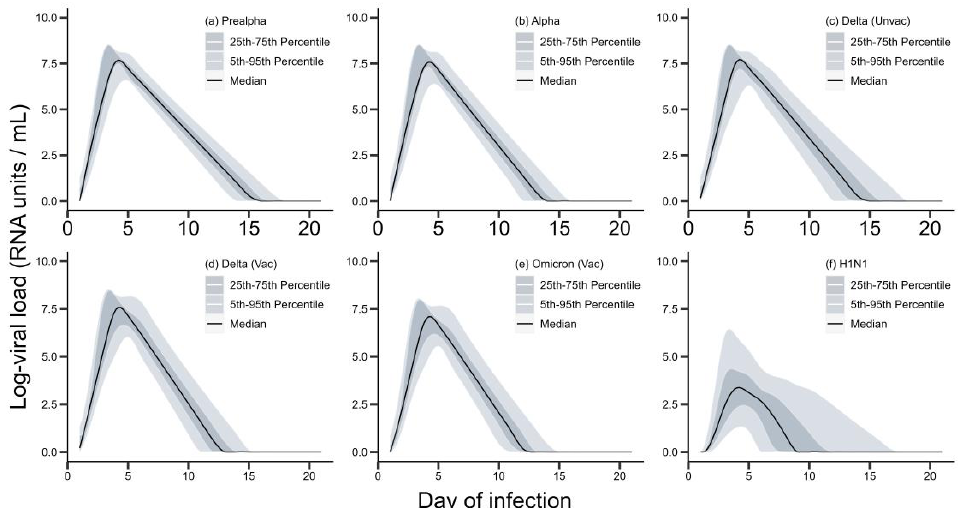
Figure 4. Log viral loads of virus variants by day of infection for ( a ) prealpha, ( b ) alpha, ( c ) delta (unvaccinated), ( d ) delta (vaccinated), ( e ) omicron (vaccinated) and ( f ) influenza A-H1N1. The median, 25th, 75th, 5th and 95th percentiles of log viral loads are presented by day of infection for each virus variant. All log viral loads and their rates of change are reported in log mRNA units/mL. The log viral load medians and percentiles for all the SARS-CoV-2 variants follow qualitatively similar trajectories, with relatively narrow percentile bands around a uni- modal median curve, having peaks around 7.5 on day 4. The variant with the lowest me- dian peak, omicron (vaccinated), had a peak log viral load of 6.99 (4.67, 7.76) on day 4. Delta (unvaccinated) showed the widest percentile bands among the SARS-CoV-2 vari- ants. The percentile bands for influenza A-H1N1 are much wider, and the unimodal me- dian curve has a much lower peak at 3.36 (1.28, 6.06) on day 4. Similar average rates of decline characterized the median curves of prealpha, alpha and delta (unvaccinated) as well as of influenza A-H1N1 with rates of 0.635, 0.683, 0.692 and 0.672 per day, respec- tively. Delta (vaccinated) and omicron (vaccinated) showed higher average rates of de- cline of 0.830 and 0.777, respectively. The viral load trajectories of the five SARS-CoV-2 variants studied have relatively small quantitative differences. One of the main differences is in the variance in the viral load on a given day of infection, with the largest variances exhibited by delta (unvac- cinated). In contrast, the viral load trajectories of influenza A-H1N1 reflected much greater variances in viral load on given days of infection. This suggests a higher frequency for influenza A-H1N1 of unusually high and unusually low viral loads relative to the median for given days, as well as a higher frequency of longer infections. Viral load trajectories for influenza A-H1N1 also had a much lower median peak than those of SARS-CoV-2 variants’ trajectories but similar rates of decline for the median curve, showing that in general influenza A-H1N1 infections tended to yield lower viral loads on given days of infection. 3.2. Relative Total TRs for ART-Based Strategies Figure 5 presents the mean relative total TR by strategy for ART-based strategies, by virus variant.